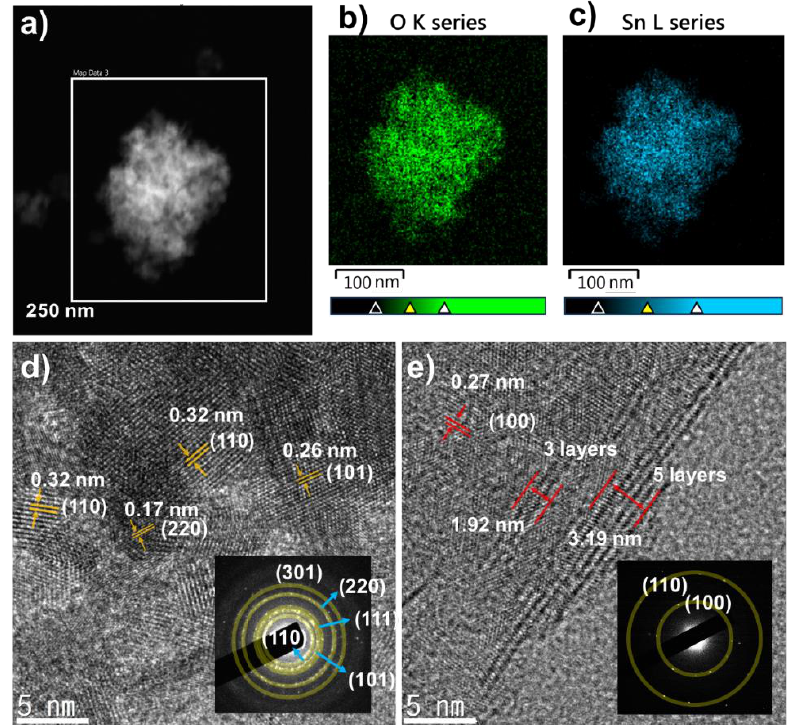
Figure 4. ( a ) Transmission electron microscope (TEM) image of SnO 2 NP; energy-dispersive X-ray spectroscopy (EDS) mapping of the elements ( b ) O and ( c ) Sn; ( d ) high-resolution TEM (HRTEM) image of SnO 2 NP with inset selected-area electron diffraction (SAED) pattern; ( e ) exfoliated MoS 2 NS with inset SAED pattern.